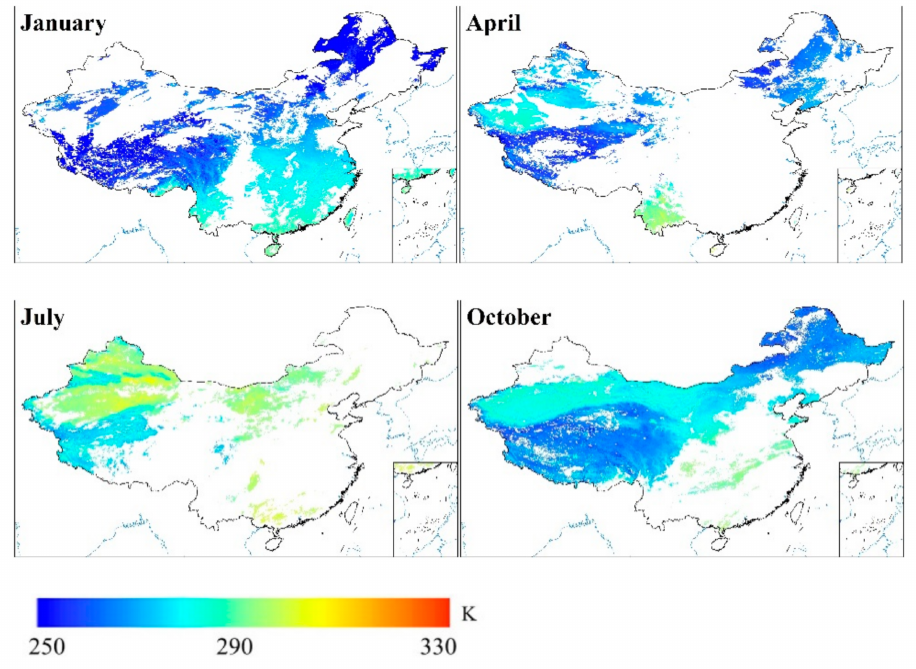
Figure 5. Spatial distributions of MODIS LST during nighttime of the 17th, 107th, 196th, and 291st days of the year 2010, representing different